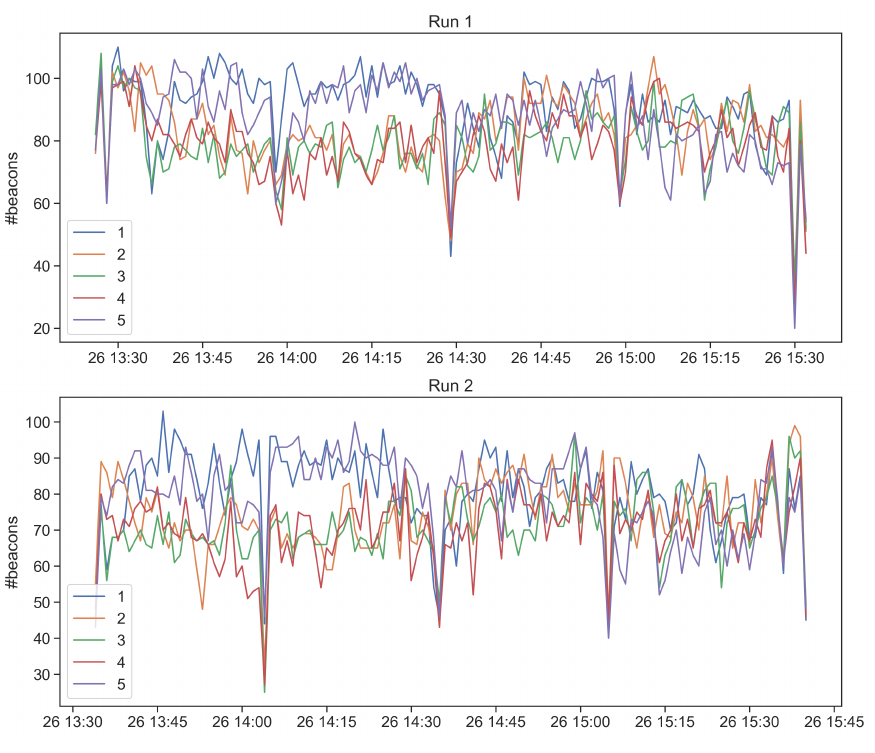
Figure 8. Number of beacons collected in T 2 for each run and for each of the 5 tags.